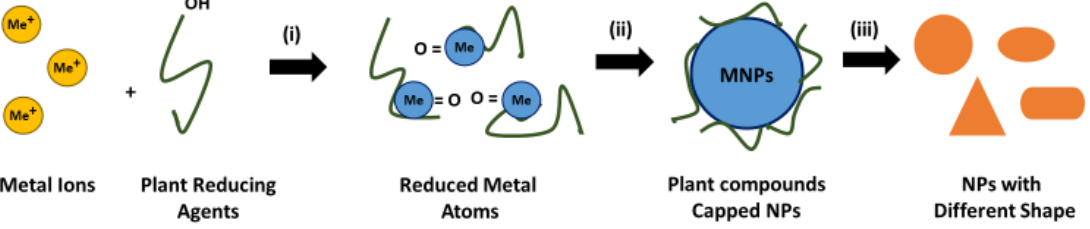
Figure 1. The mechanism of biosynthesis of metal nanoparticles using plant extracts: (i) activation stage, (ii) growth stage, and (iii) termination stage.